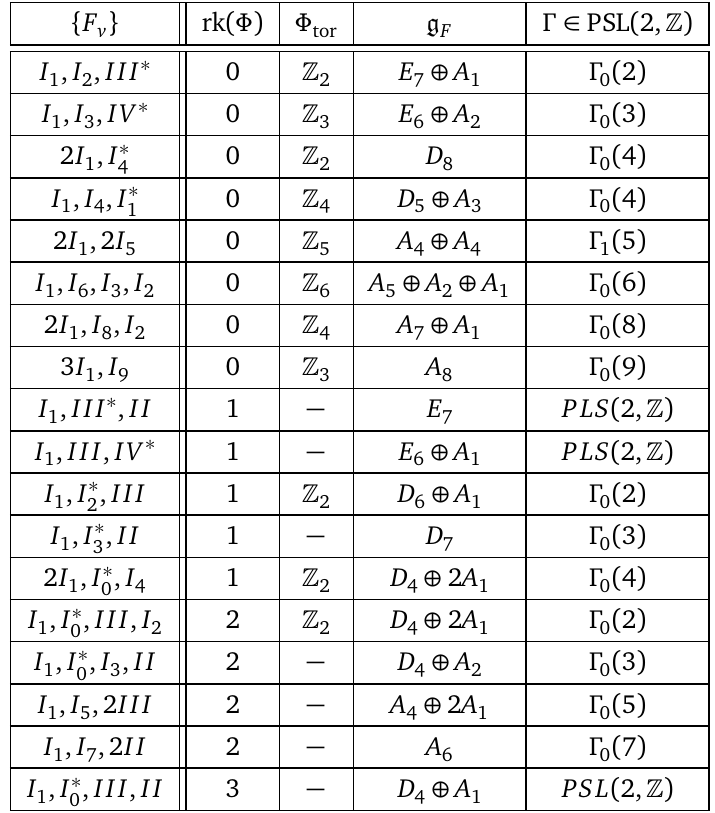
Table 13: Configurations on the Coulomb branch of the D lar with respect to a congruence subgroup. The flavour algebra excludes the abelian u ( 1 )